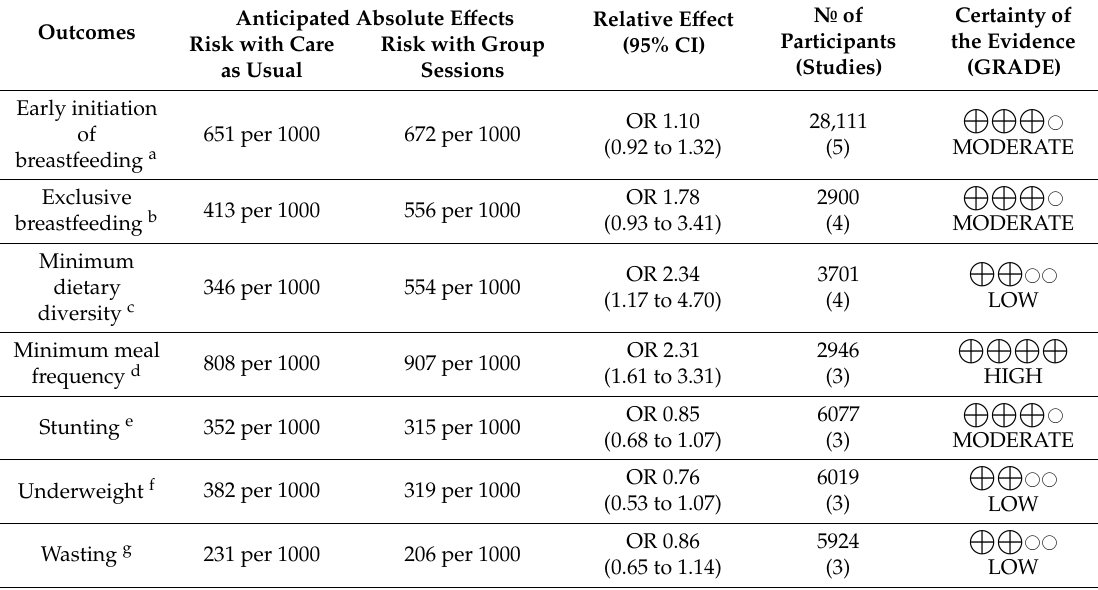
Table 2. Summary of outcomes for mother / peer group